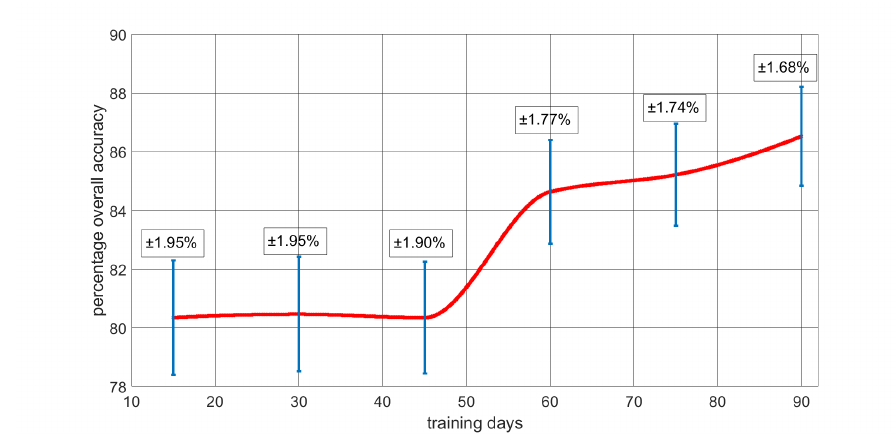
Figure 7. Percentage overall accuracy for different training